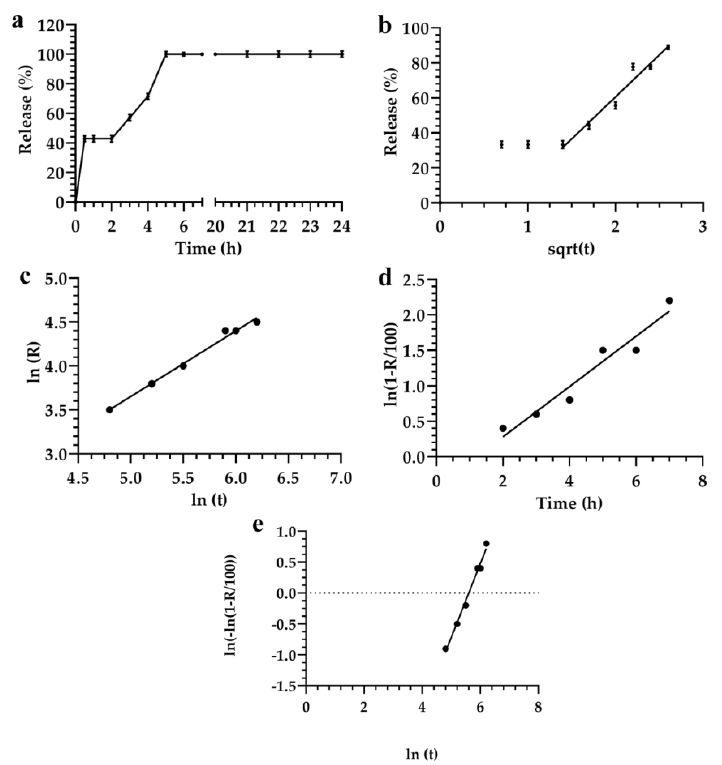
Figure 3. Evaluation of the release profile of fluorescein from the monoglyceride colloidal liquid crystal formulation 2, using the following mathematical models: ( a ) Linear regression; ( b ) Higuchi; ( c ) Siepman – Peppas; ( d ) Noyes – Whitney; and ( e ) Weibull. Data represented the average of three different measurements. Error bars, if not shown, are within the symbols.